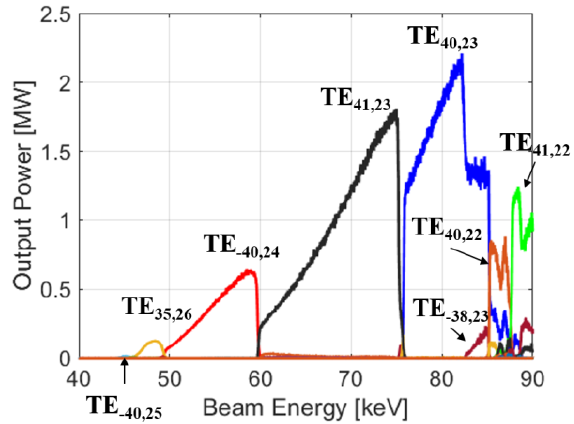
Fig. 7. Realistic start-up scenario with the existing coaxial cavity at 8.15 T and I beam = 70 A including the non-linear uptaper using the magnetic field profile proposal from the new SC magnet and the gun parameters from the new coaxial MIG.